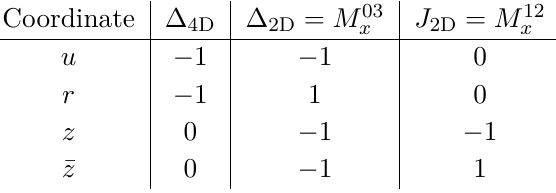
Table 1 . Various scaling dimensions for our Bondi